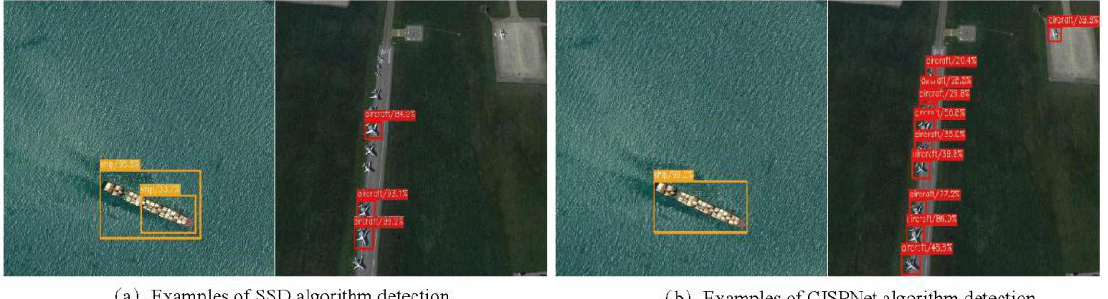
Figure 1. Conventional single shot multibox detector (SSD) vs. The proposed context information scene perception (CISP)Net. ( a ) SSD detects ship targets with overlapping boxes and the small aircraft targets that cannot be located. ( b ) Ship and small aircraft targets that can be located by the proposed CISPNet.